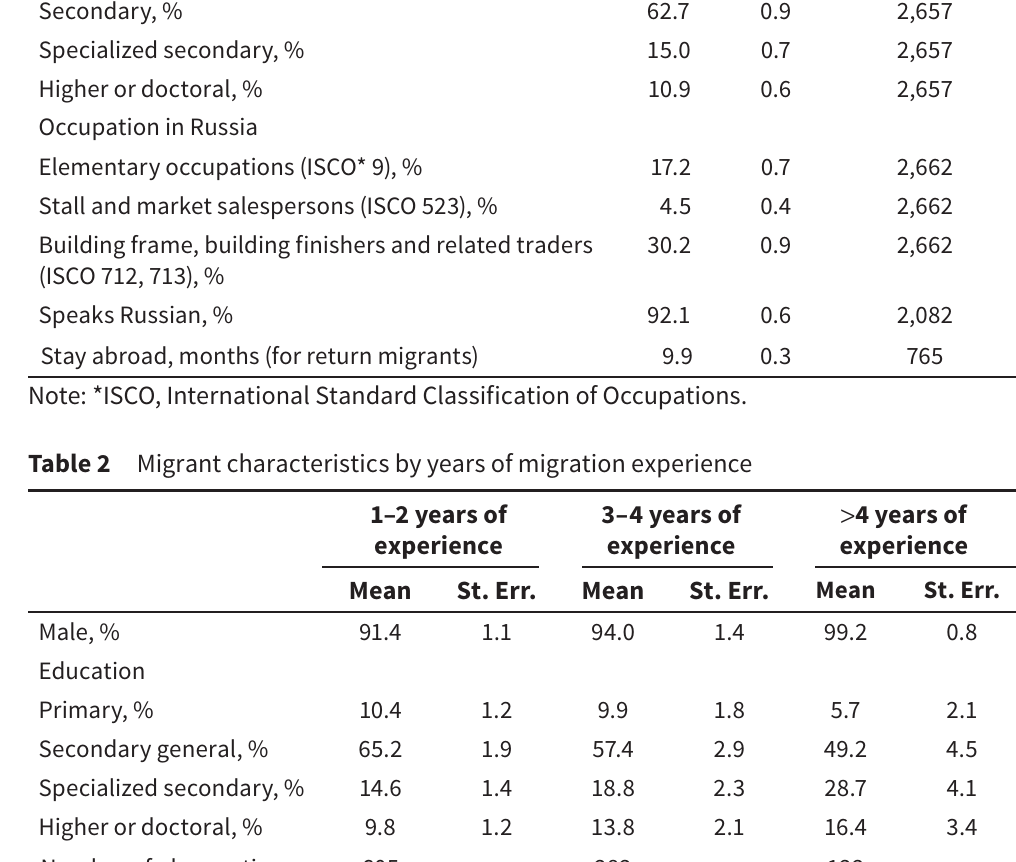
Number of Mean St. Err. observations